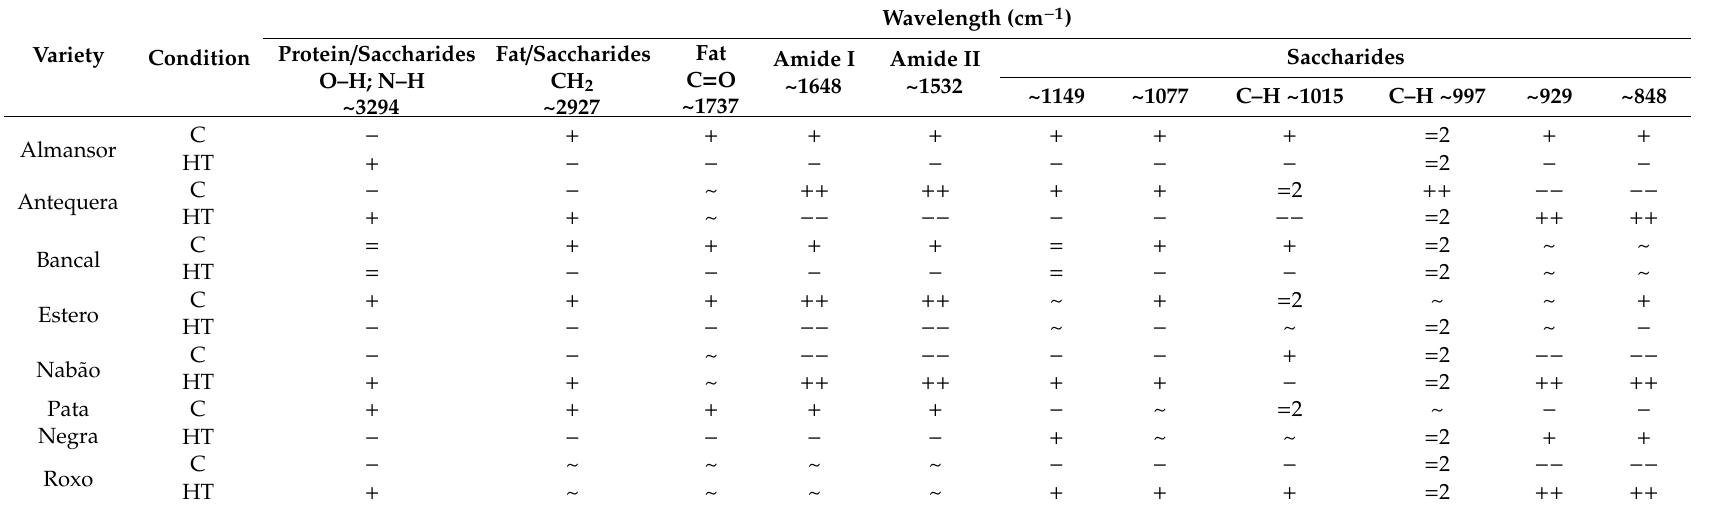
Table 1. Comparison between peaks’ high of control and treated average spectra of wheat milled grains after Min-Max normalization.